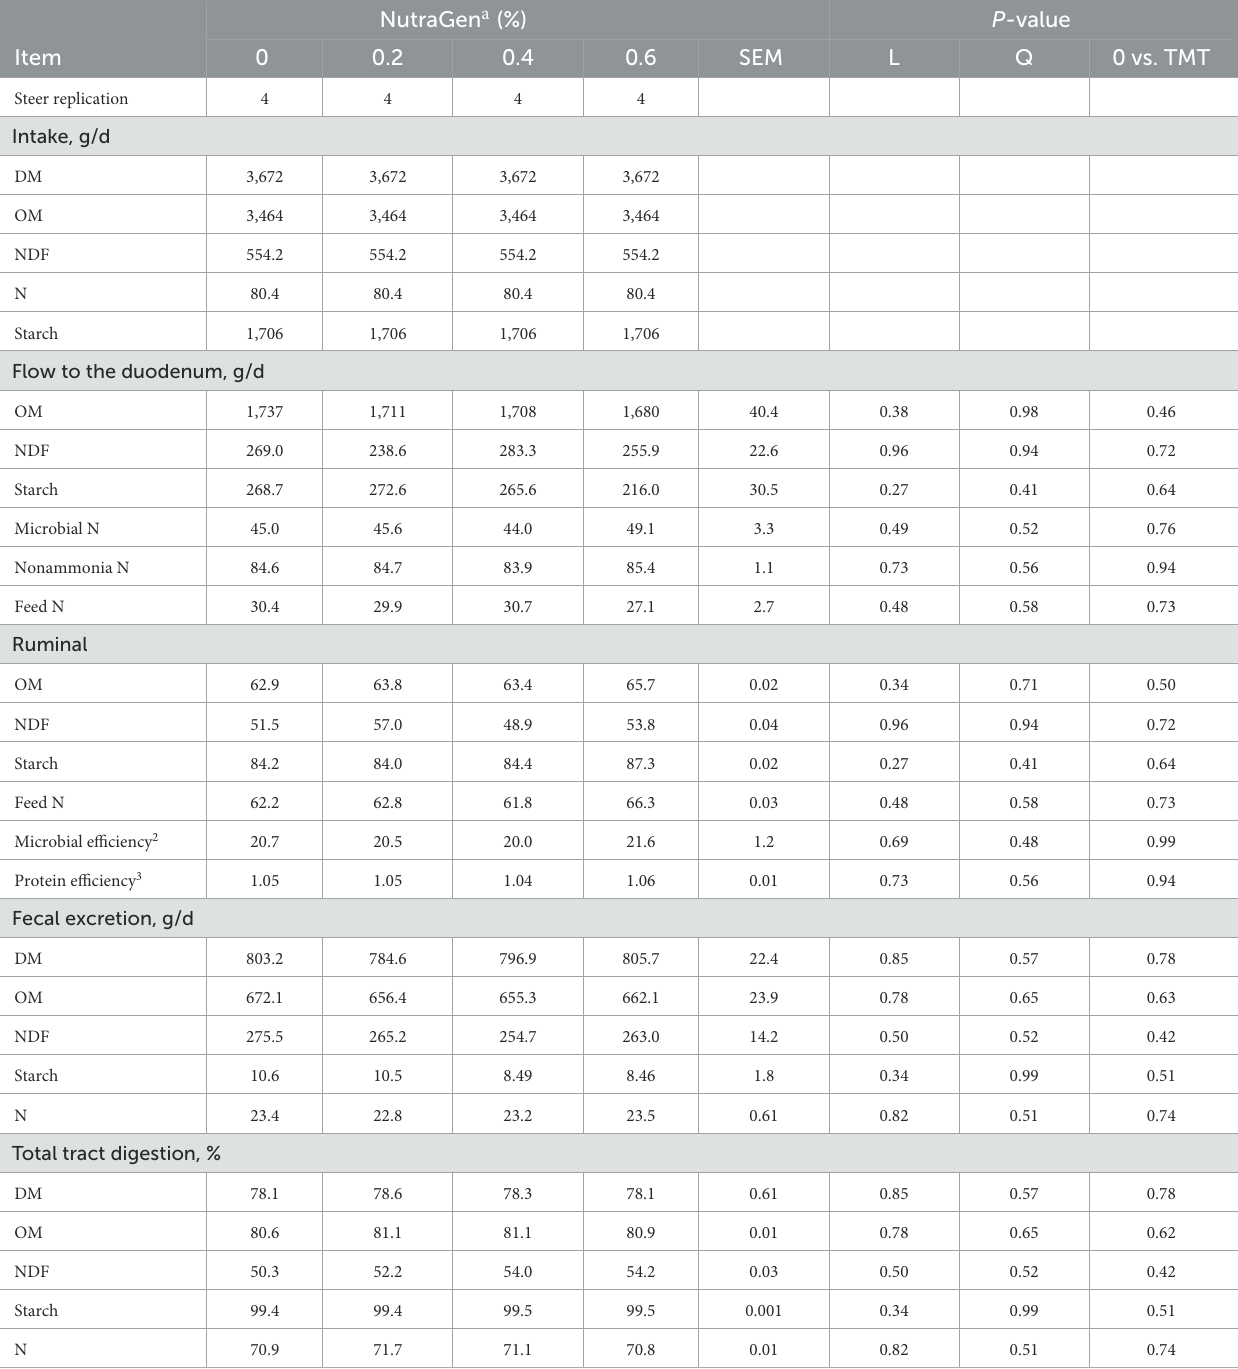
TABLE 5 Effects of feeding NutraGen supplement on characteristics of ruminal and total tract